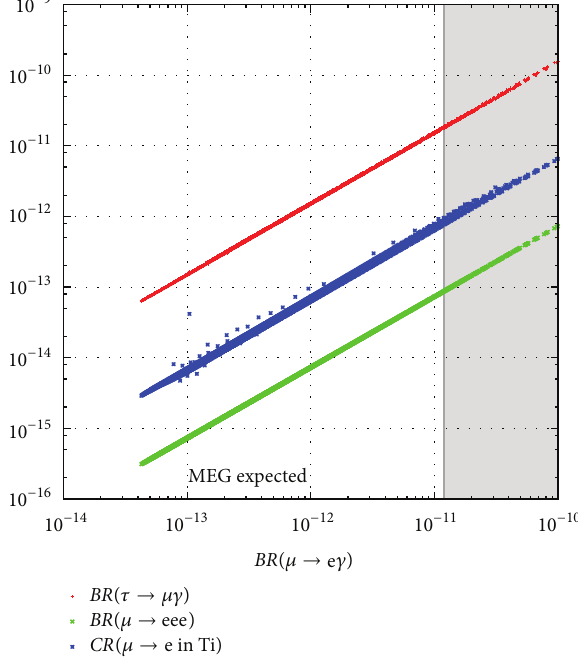
Figure 4: 𝐵𝑅 for 𝜏 → 𝜇𝛾 (red), 𝜇 → eee (green), and 𝜇 − 𝐴 → e − 𝐴 conversion in Ti (blue) as a function of 𝐵𝑅(𝜇 → e 𝛾) in a SO(10) based SUSY-GUT model (adapted from [73]). The grey area was excluded by the MEGA experiment [88,